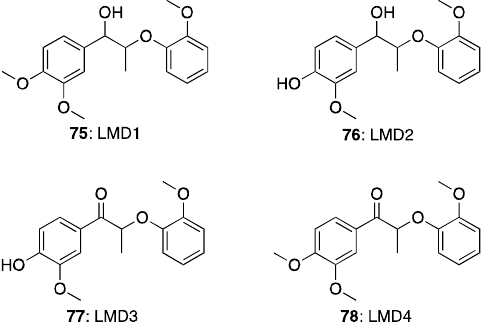
Figure 6. Lignin model